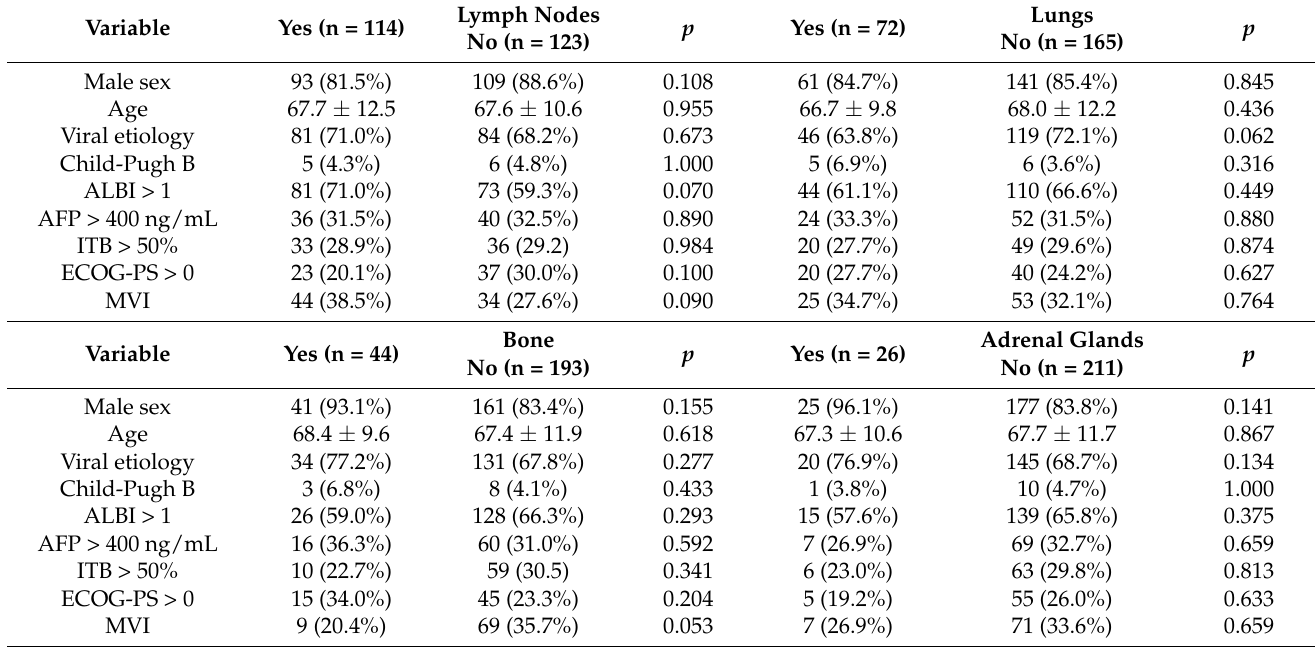
Table 2. Baseline characteristics of patients with lymph node, lung, bone and adrenal gland metas- tases compared with the rest of study population.